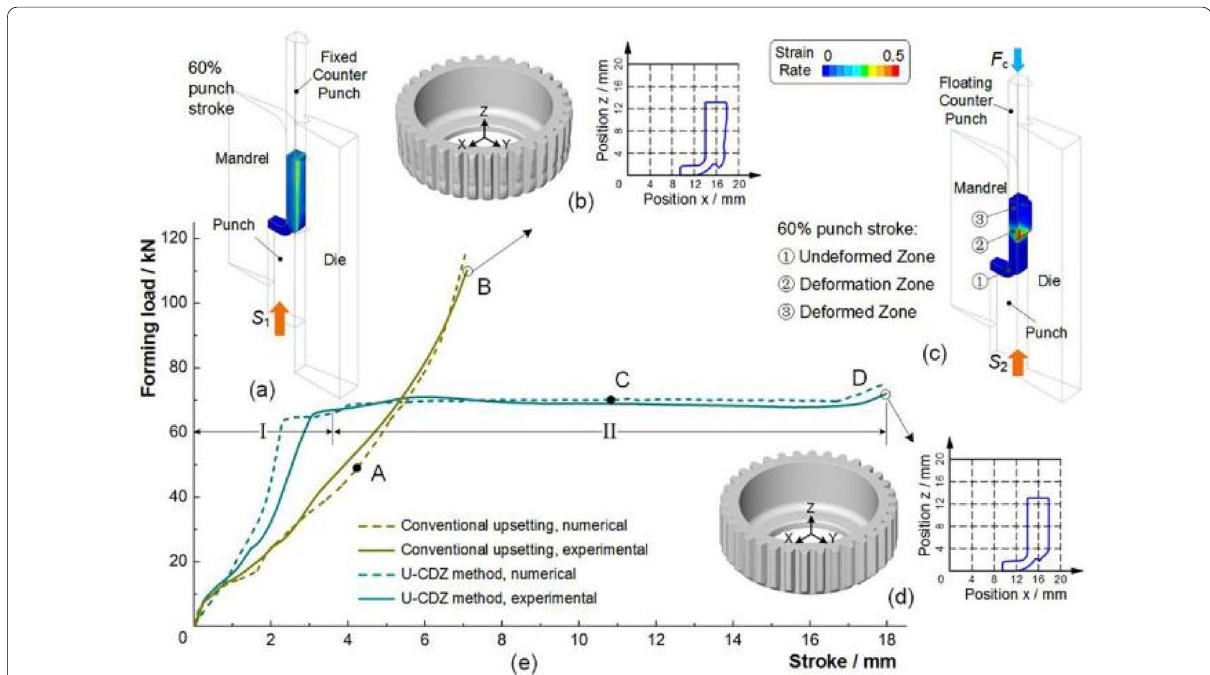
Figure 12 Comparison between conventional upsetting and U-CDZ methods: ( a ) material flow based on conventional method (60% punch stroke), ( b ) digital models and vertical cross-section at tooth tip obtained using ATOS optical scanner, ( c ) material flow based on U-CDZ method (60% punch stroke), ( d ) digital models and vertical cross-section at tooth tip obtained using ATOS optical scanner, ( e ) forming load and displacement